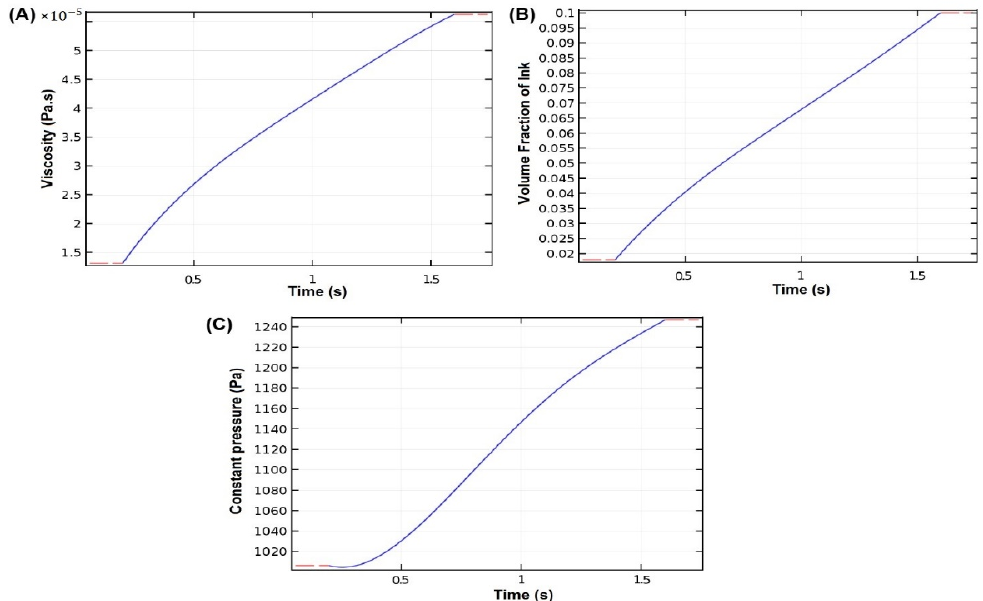
Figure 9. ( A ) Viscosity of ink; ( B ) volume Fraction of ink; and ( C ) constant pressure of 3D printing.